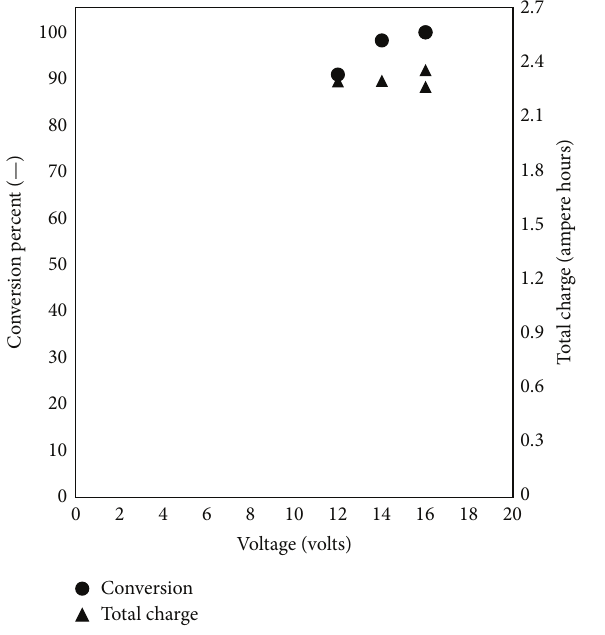
Figure 8: Conversion percent (—) and total charge (ampere hour) versus voltage (volts) for 2N feed concentration.